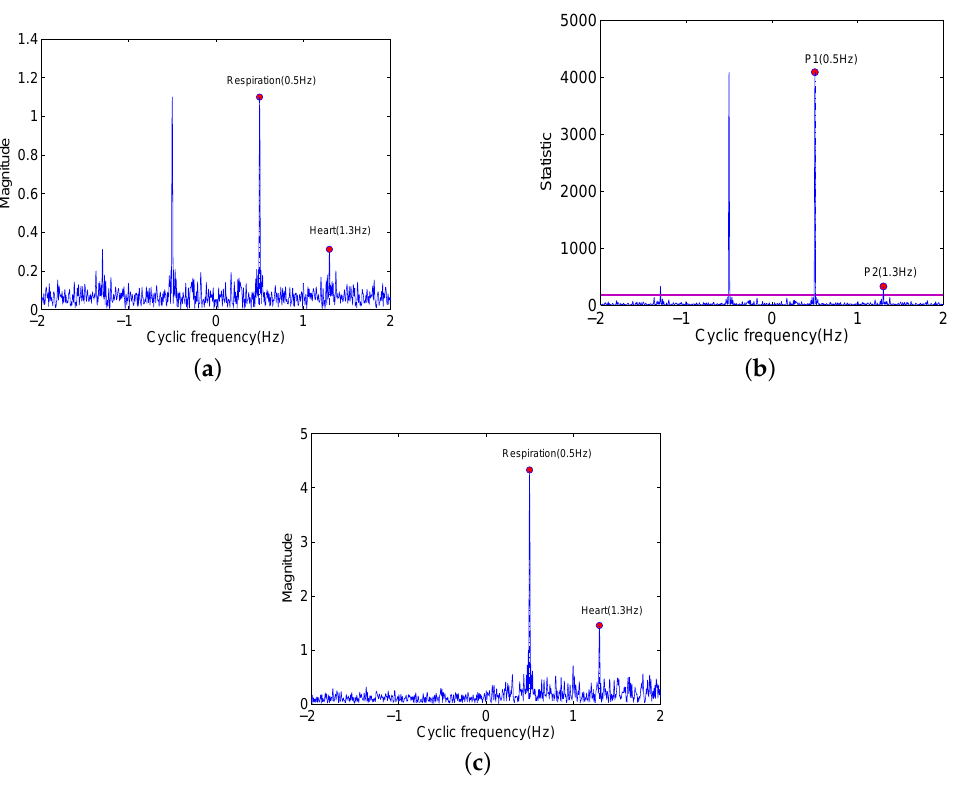
Figure 4. TOCC of the received signal. ( a ) TOCC of the received signal; ( b ) Test statistic (purple line denotes the threshold); ( c ) TOCC of the received signal in Hilbert